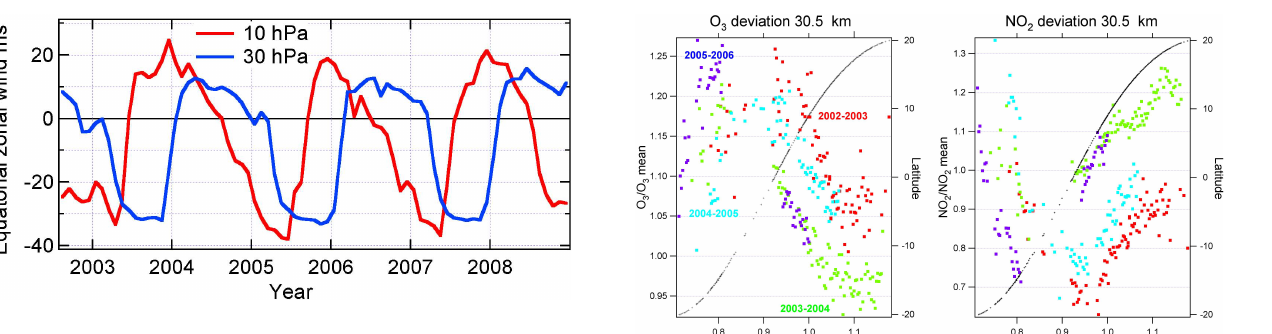
Fig. 2. Evolution of the equatorial QBO wind at 10 and 30hPa updated from Naujokat (1986).